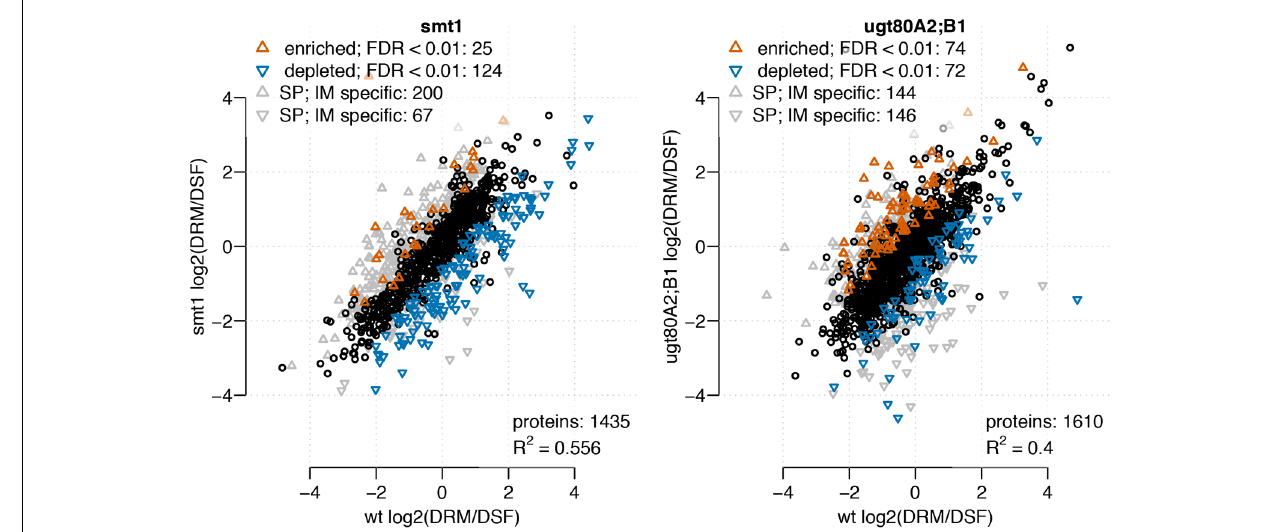
FIGURE 1 | Scatterplot of log 2 transformed DRM/DSF protein abundance ratios from smt1 ( left ) and ugt80A2;B1 ( right ), each in comparison to DRM/DSF distributions in wildtype. Proteins with Unicorn scores above the threshold defining a false discovery rate lower than 1% were considered to be significantly altered in their distribution between wildtype and the respective mutant. In smt1